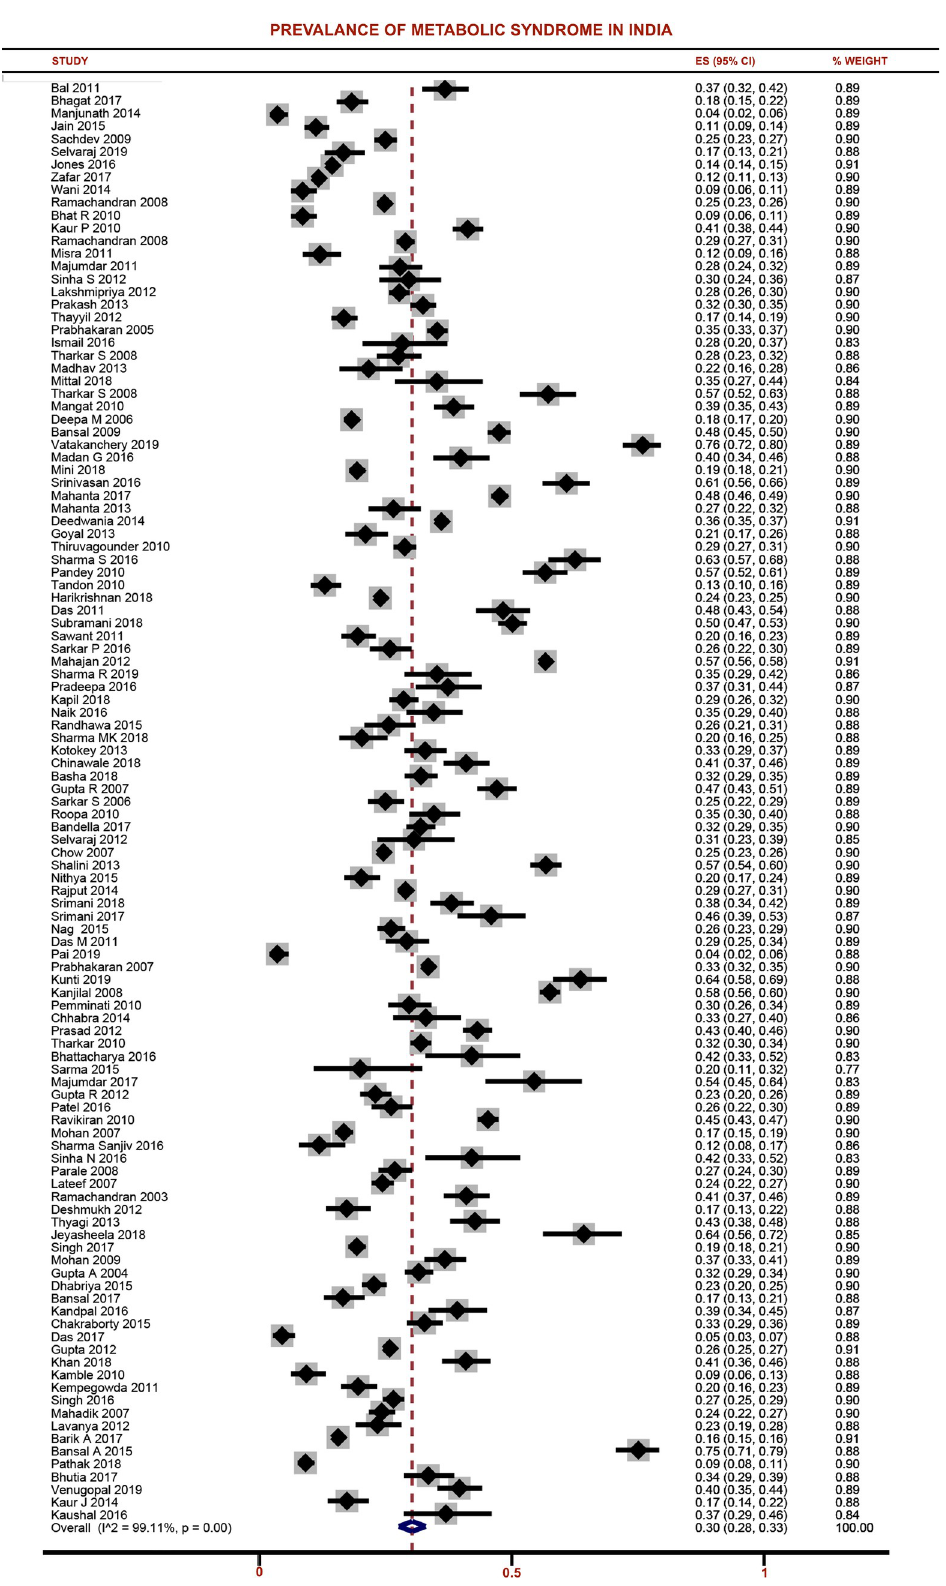
Fig 2. Forest plot showing the prevalence of metabolic syndrome among adult population in India. https://doi.org/10.1371/journal.pone.0240971.g002 PLOS ONE | https://doi.org/10.1371/journal.pone.0240971 October 19,